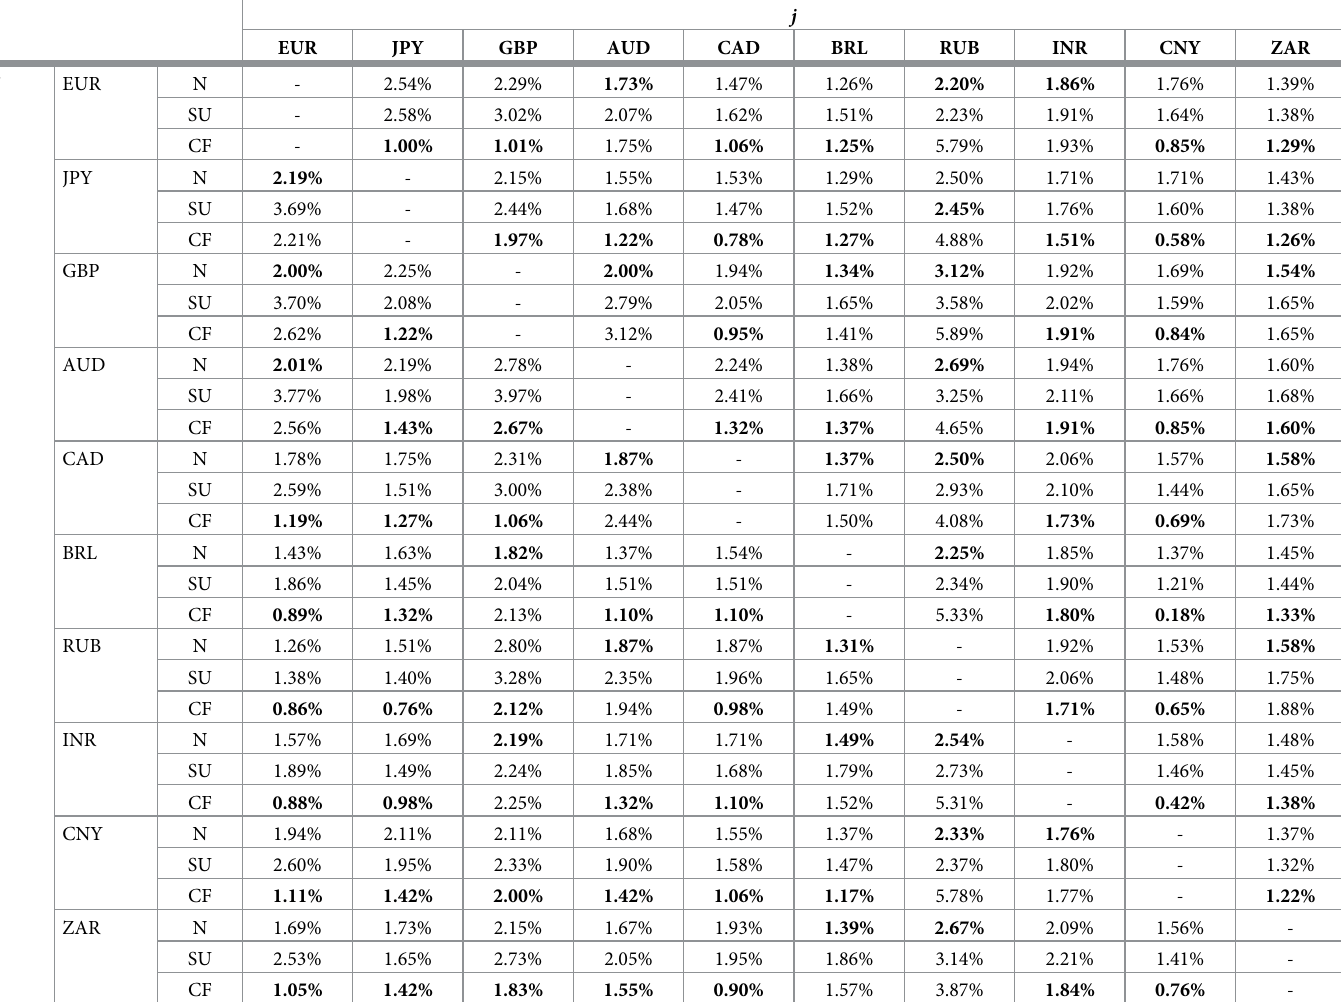
of the forecasted CoVaR 5 % j j i